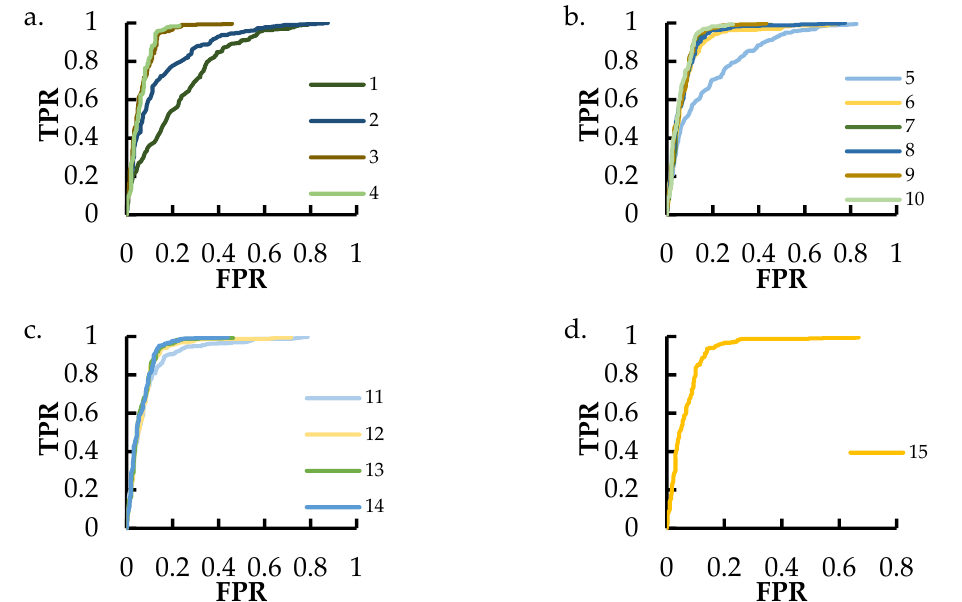
Figure 7. Extraction results of quadrat 1 combination at different phenological stages. ( a ) Single phenophase; ( b ) Combined time series of dual phenology; ( c ) Combined time series of triple phe- nology; ( d ) Full phenological stage with 1–15 corresponding to the combination numbers of differ-